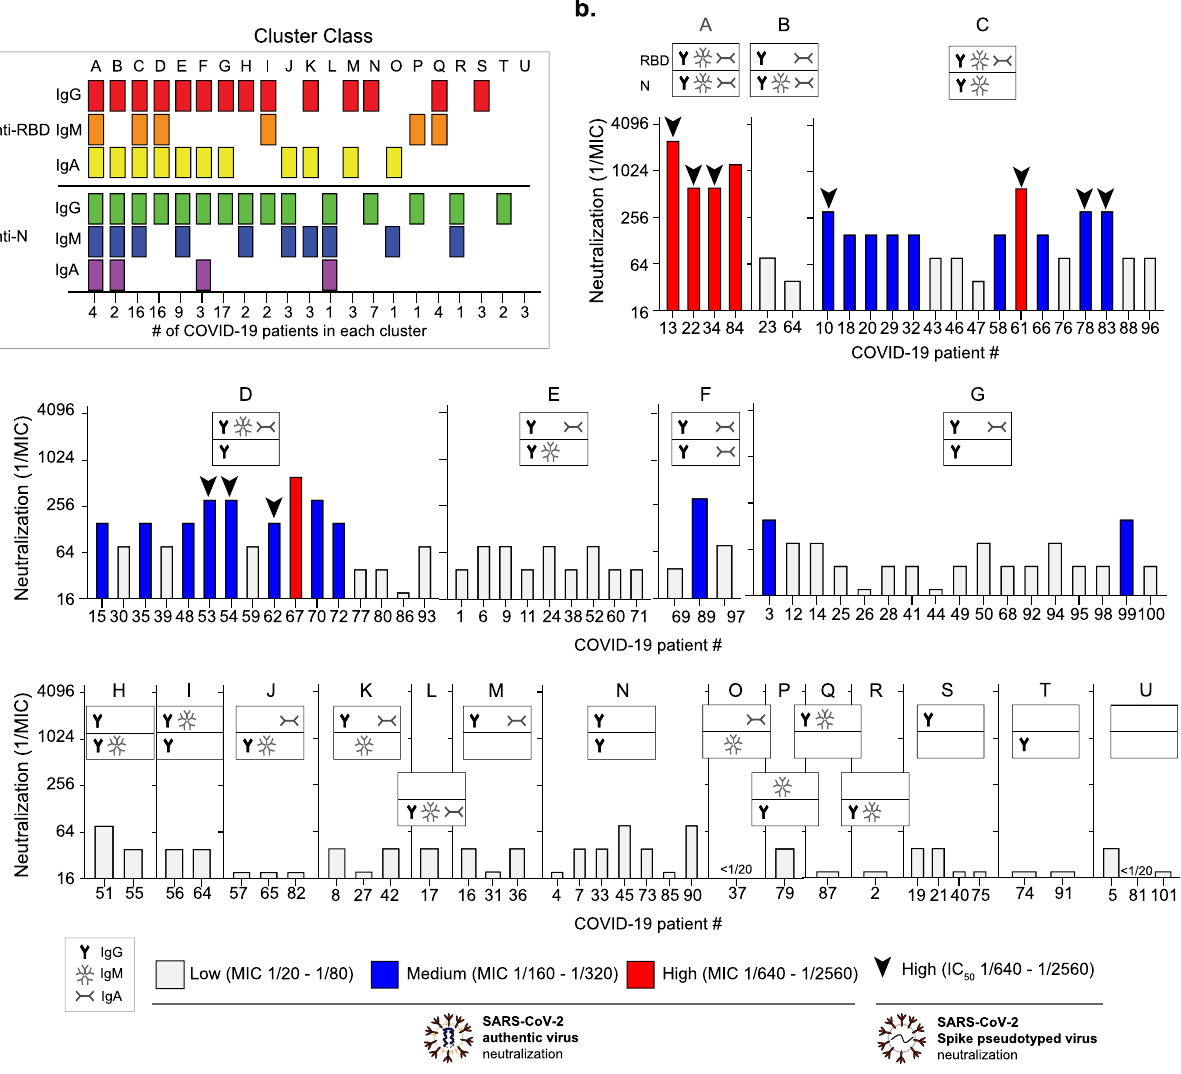
Figure 5. Clustering analysis of individual SARS-CoV-2 antibody response. ( a ) Combination of antibody isotypes in individual patient sera defining different cluster classes. ELISA titers were categorized as positive (ELISA titers > cutoff) or negative (ELISA titer < cutoff) for each sample for each individual antibody isotype. Clusters were made based on the presence or absence of specific isotypes (Cluster A to U). The number of patients in each cluster is shown on the x axis. ( b ) Neutralization levels shown for each individual antibody